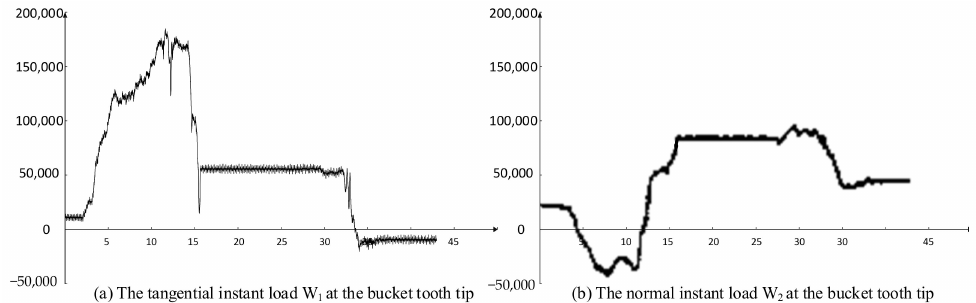
Figure 11. The instant load W 1 and W 2 at the bucket tooth